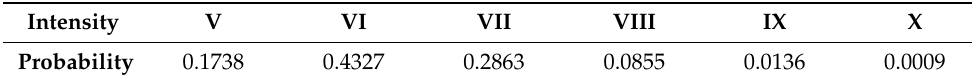
Table 9. Occurrence probability of the seismic intensity.